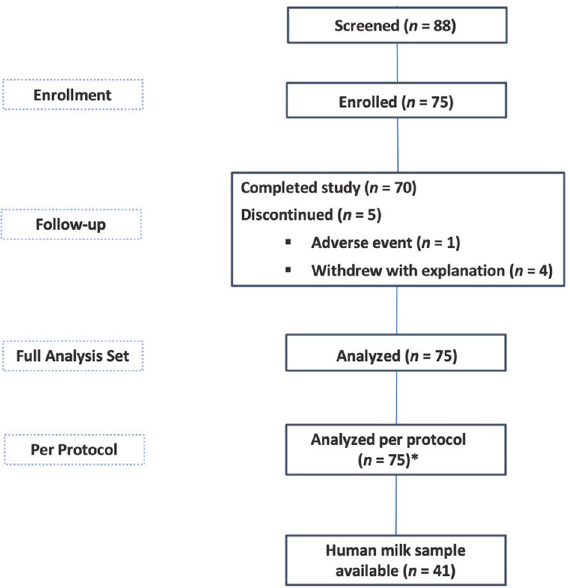
Figure 1. Study design and subject flow chart. *Only 1 enrolled subject had major protocol deviation (“Informed consent for breastmilk sample is signed butbreastmilk sample is not collected”). This subject was not excluded from the per-protocol set for this deviation andthus the full analytic set and per protocol datasets both include 75